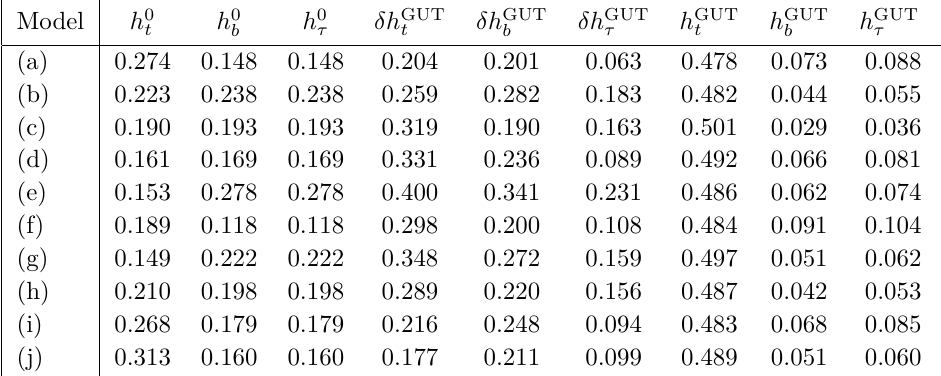
Table 5 . The magnitude of the contributions to the top, bottom, and tau Yukawa couplings from cubic interactions (columns 2–4), from quartic interactions (columns 5–7) and the magnitude of their complex sum (columns 8–10) at the GUT scale for the parameter set of table 4. The Yukawa couplings are in general complex and we add the contributions of the cubic and quartic interactions as complex numbers and exhibit only their magnitudes in the table.